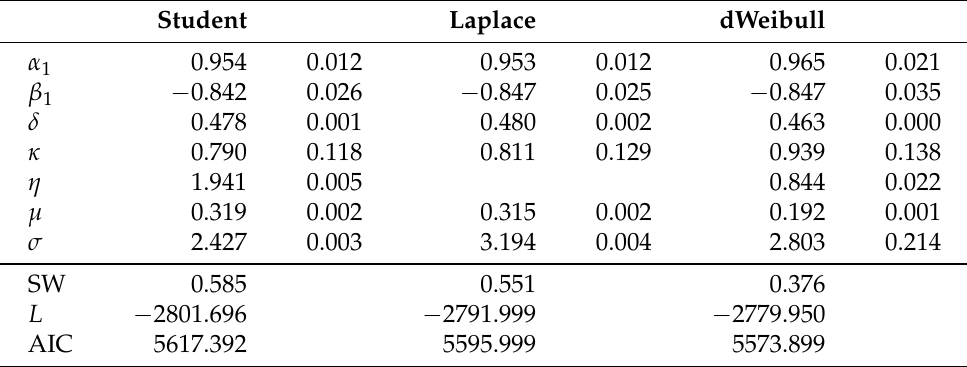
Table 2. VT(2)-ARMA(1,1) model with three different margins: Student-t, Laplace, double Weibull. Parameter estimates, standard errors (alongside estimates) and information about the fit: SW denotes Shapiro–Wilks p -value; L is the maximized value of the log-likelihood and AIC is the Akaike